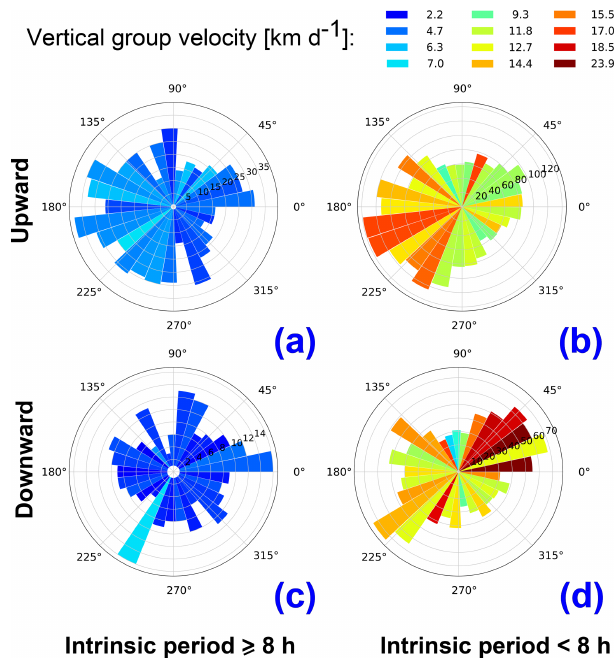
Figure 17. Polar histogram of the upward (a, b) and downward- propagating (c, d) GWs separated for waves with intrinsic periods ≥ 8h (a, c) and < 8h (b, d) . The length of the bars represents the number of waves per given horizontal direction. The colors repre- sent the vertical group velocity (in kmd − 1